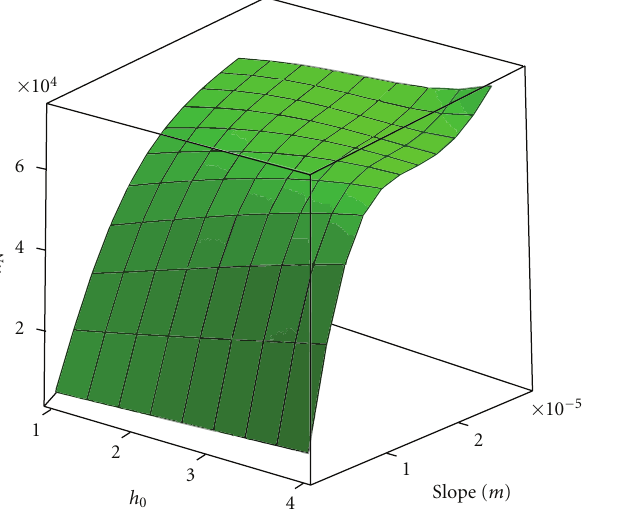
Figure 22: μ ( h 0 , β s ) for m = 2 × 10 − 5 and a = 150000.